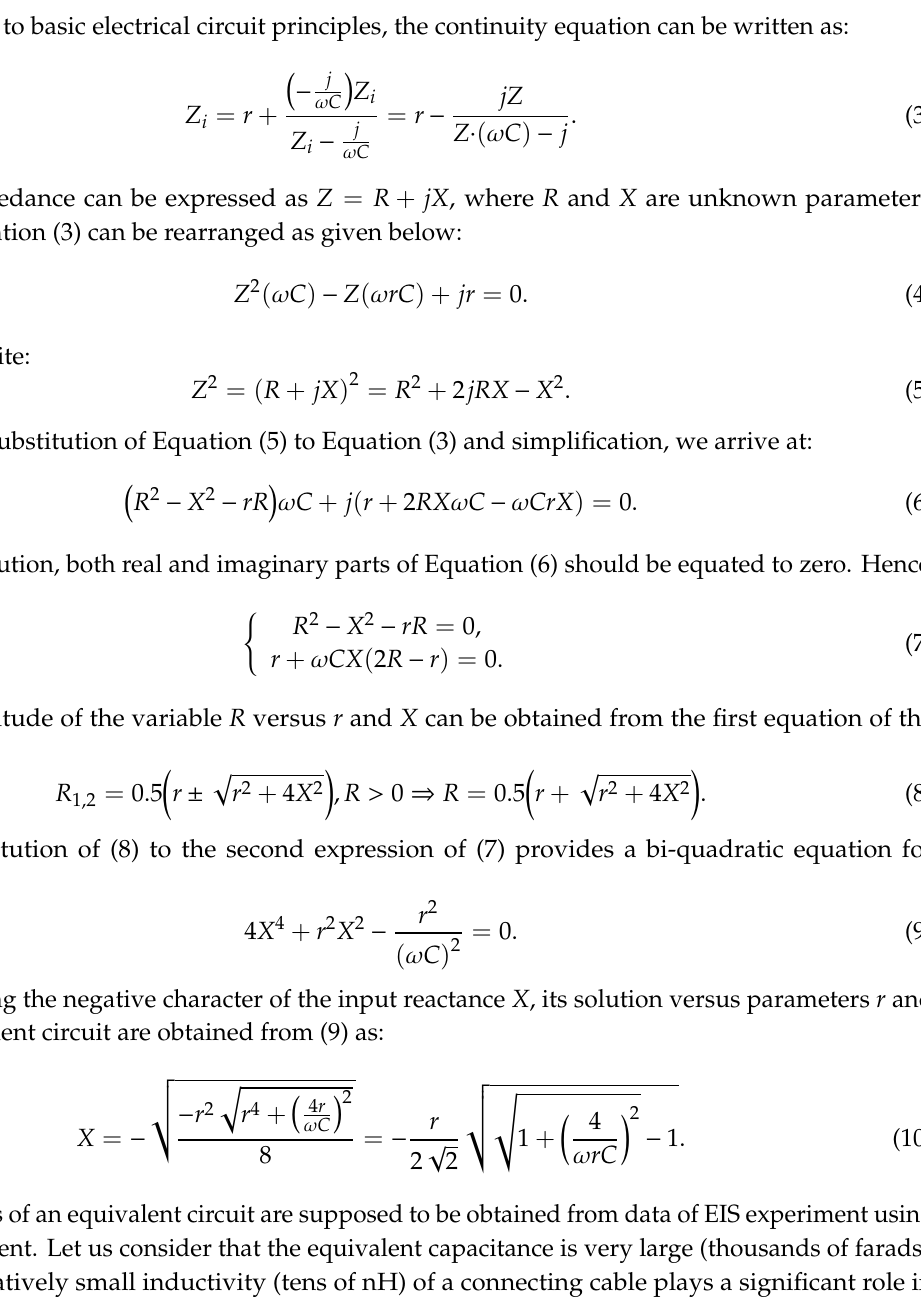
Figure 8. Equivalent circuit of a UC represented by a ladder combined from r–C chains. r : resistor; C : capacitor.